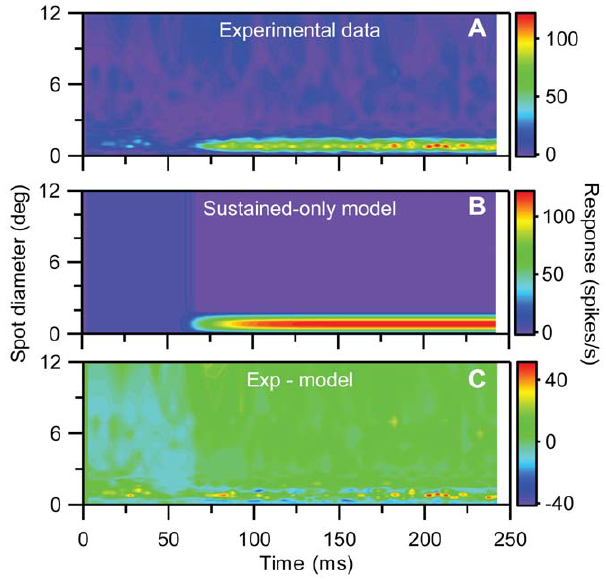
Figure 13. Fit of sustained-only model to the response data of the lagged cell in Fig. 4. A , Experimental data. B , Best fit to sustained-only model in Eq. (15). C , Deviation between experimental results (A) and model results in (B). Error e (cf. Eq. 1) is